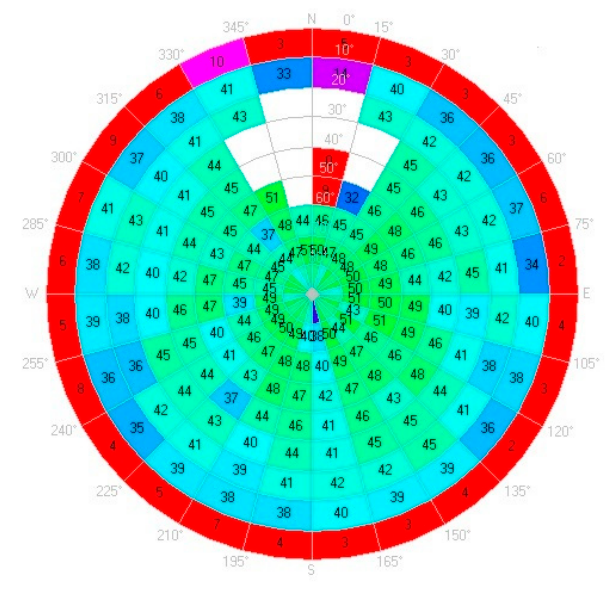
Figure 5. Sky plot of C/N 0 for LC − 1.